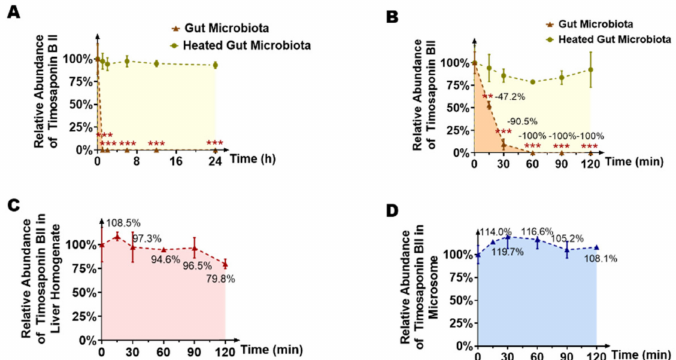
Figure 2. Timosaponin BII could be metabolized in the gut microbiota. Intestinal bacteria mainly participated in the metabolism of timosaponin BII by comparison between untreated and heated intestinal contents ( A , B ). ( A ) The level of timosaponin BII decreased during incubation with rat intestinal bacteria after 0 h, 1 h, 2 h, 6 h, 12 h, and 24 h. ( B ) The metabolic characteristic of timosaponin BII by gut microbiota in more precise spans of time. The liver may not be the metabolic site of timosaponin BII ( C , D ). ( C ) The metabolic curve of timosaponin BII by rat liver homogenate. ( D ) The metabolic curve of timosaponin BII by rat microsome. Data are presented as mean ± SD, and two-tailed Student’s t test were used for analysis (** p < 0.01, *** p <